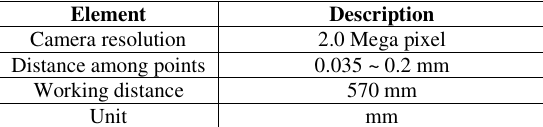
Table 2. Specification of the structured light device.